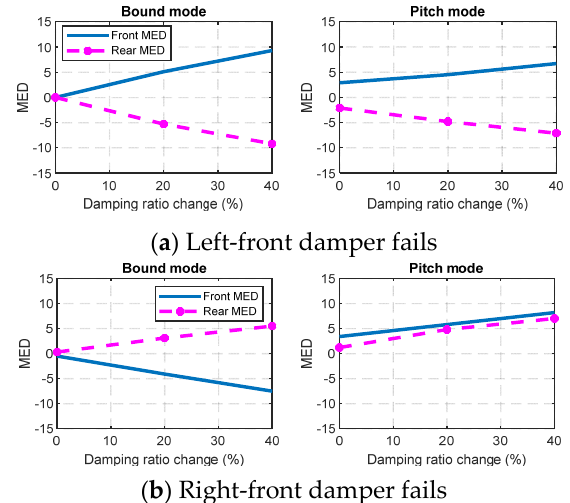
Figure 15. Changes of MED caused by different damper faults.